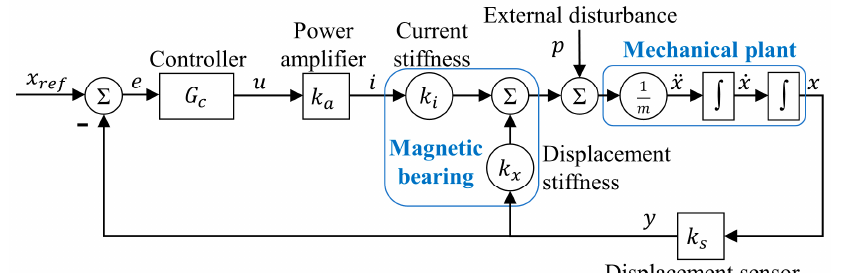
Figure 3. The AMB system control loop.